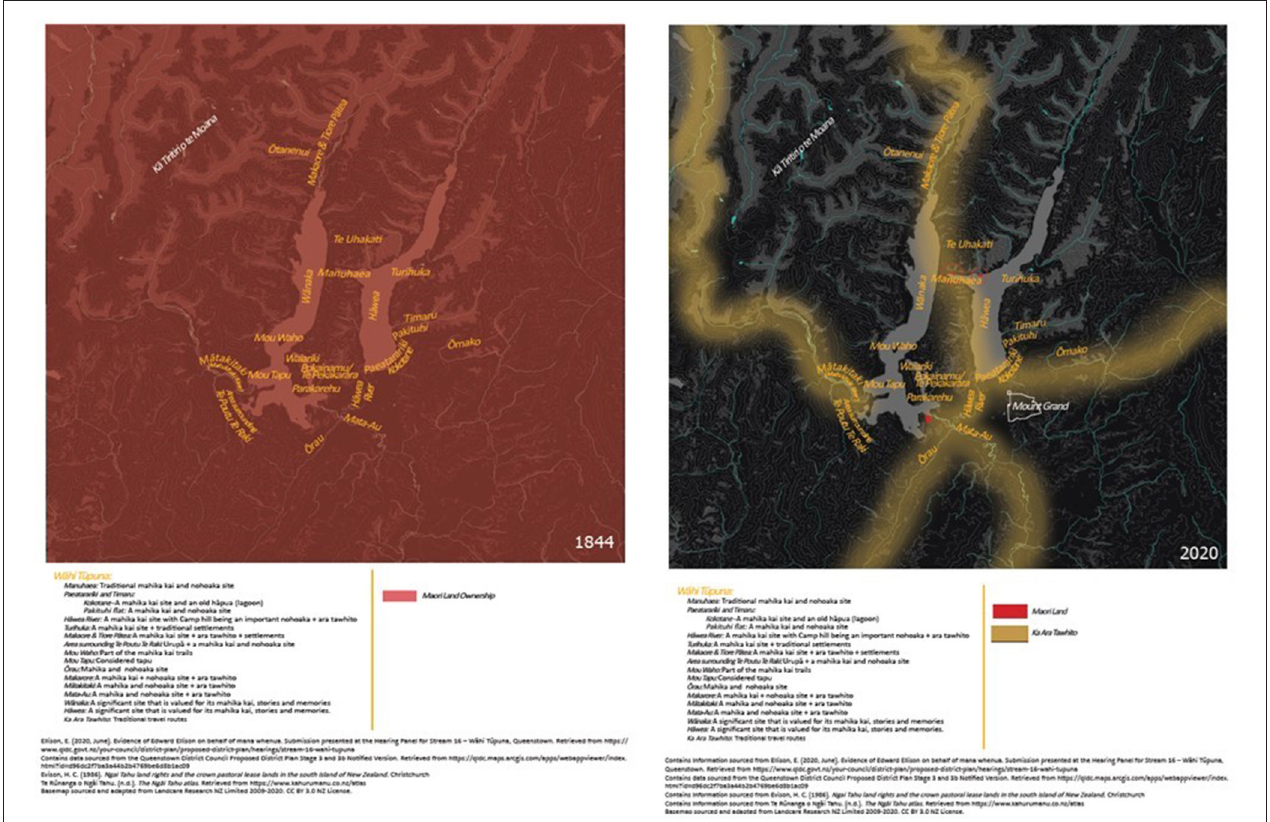
FIGURE 12 | Co-produced maps showing the transformation in land ownership in the Otago region of Te Waipounamu South Island in Aotearoa NZ. Also depicted on the map are Wahi Tupuna (sacred/ancestral places) which include Mahinga Kai (food gathering site) and Ka Ara Tawhito (seasonal migration routes).